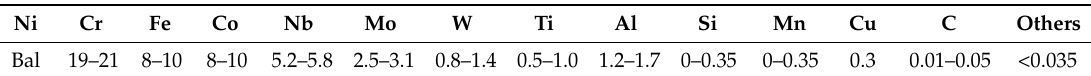
Table 1. Composition specification of 718Plus (wt